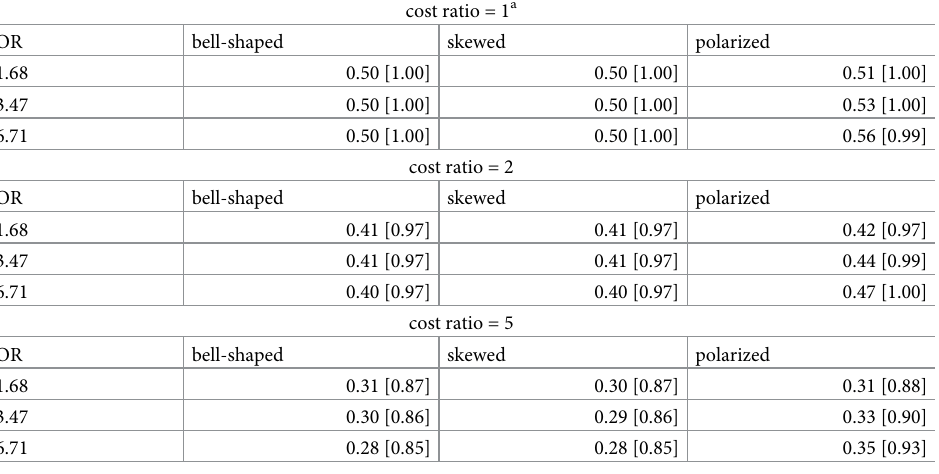
For a fixed total sample size the optimal proportion for the bell-shaped and skewed distri- bution is most often near 0.5 and the efficiency of the balanced design is higher than 0.95. For cost ratios c / c = 2 and 5 the optimal proportion of subjects in the intervention is almost I C always less than 0.5. The further the optimal proportion is away from 0.5, the lower the effi- ciency of the balanced design. This efficiency is always larger than 0.8 for the chosen cost ratios. However, for larger cost ratios the efficiency further decreases. For instance, c it is equal to 0.71 for a bell-shaped distribution with three categories and a small effect size. It can thus be concluded that the balanced design is not always the best choice. Table 2. Optimal proportion of subjects in the intervention [efficiency of the balanced design] for five response